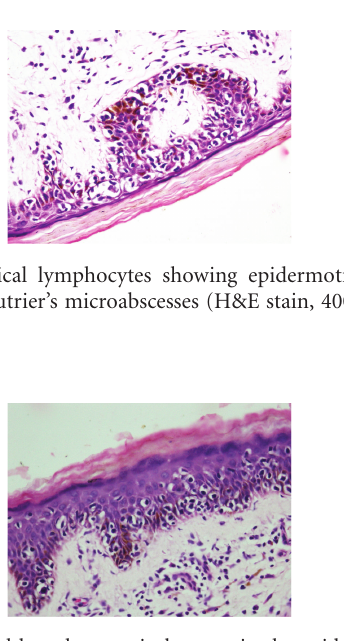
Figure 8: Aypical lymphocytes in lacunae in the epidermis (H&E stain, 400x) (patient